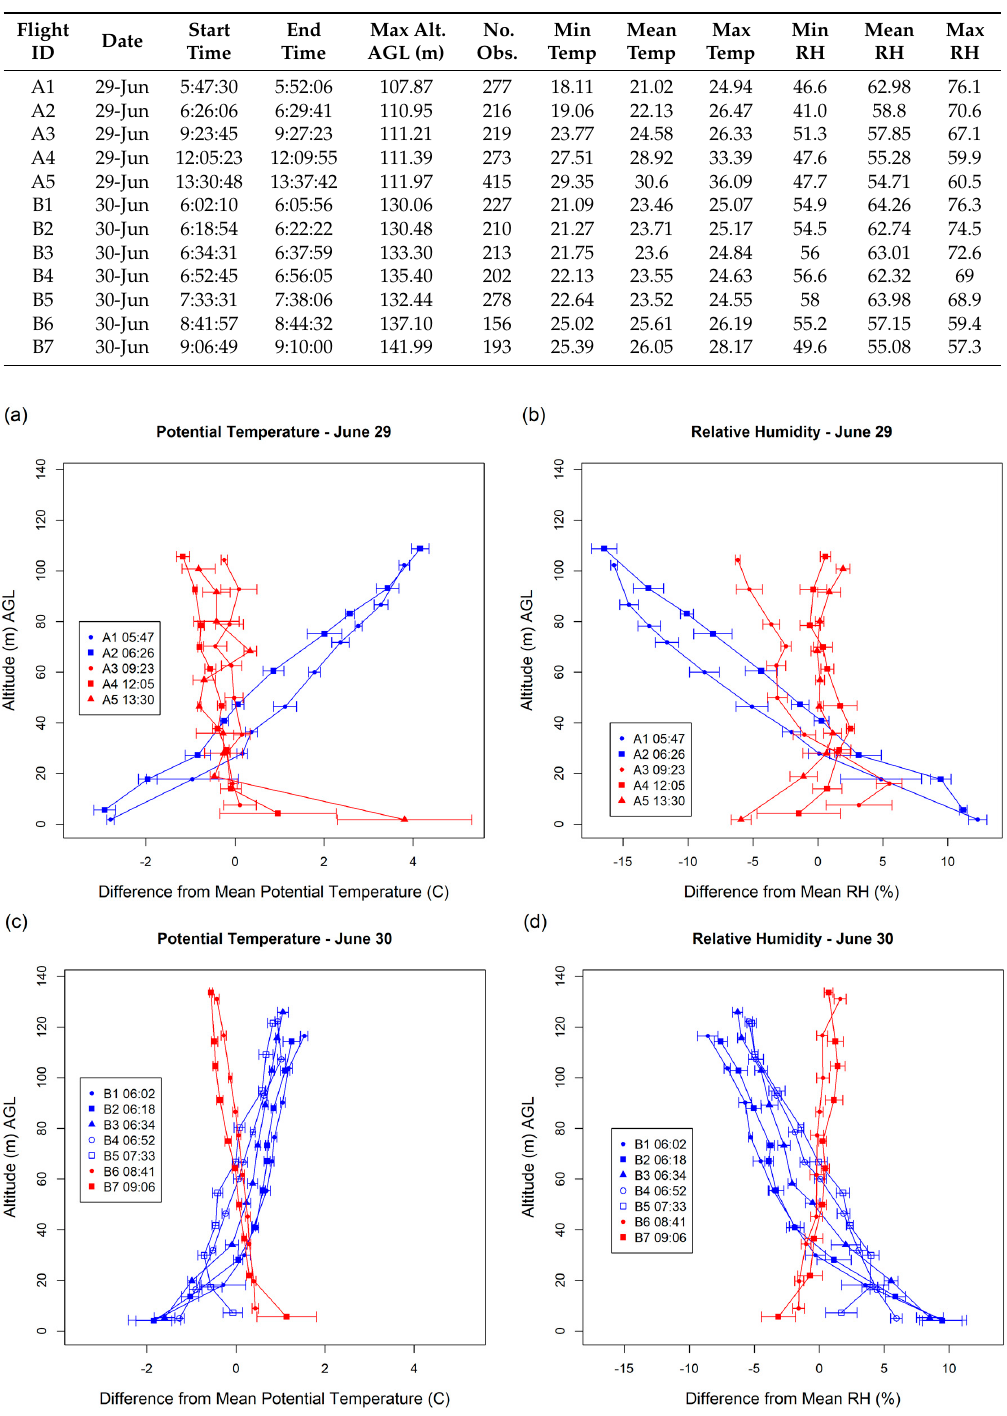
Table 1. Flight information and summary statistics. Temperature (Temp) is reported in degrees Celsius and relative humidity (RH) is reported in percentages. Start times note the start of each ascent and end times are the time at which the flight reached its maximum altitude. Flight times are in Central Daylight Time (UTC-5).